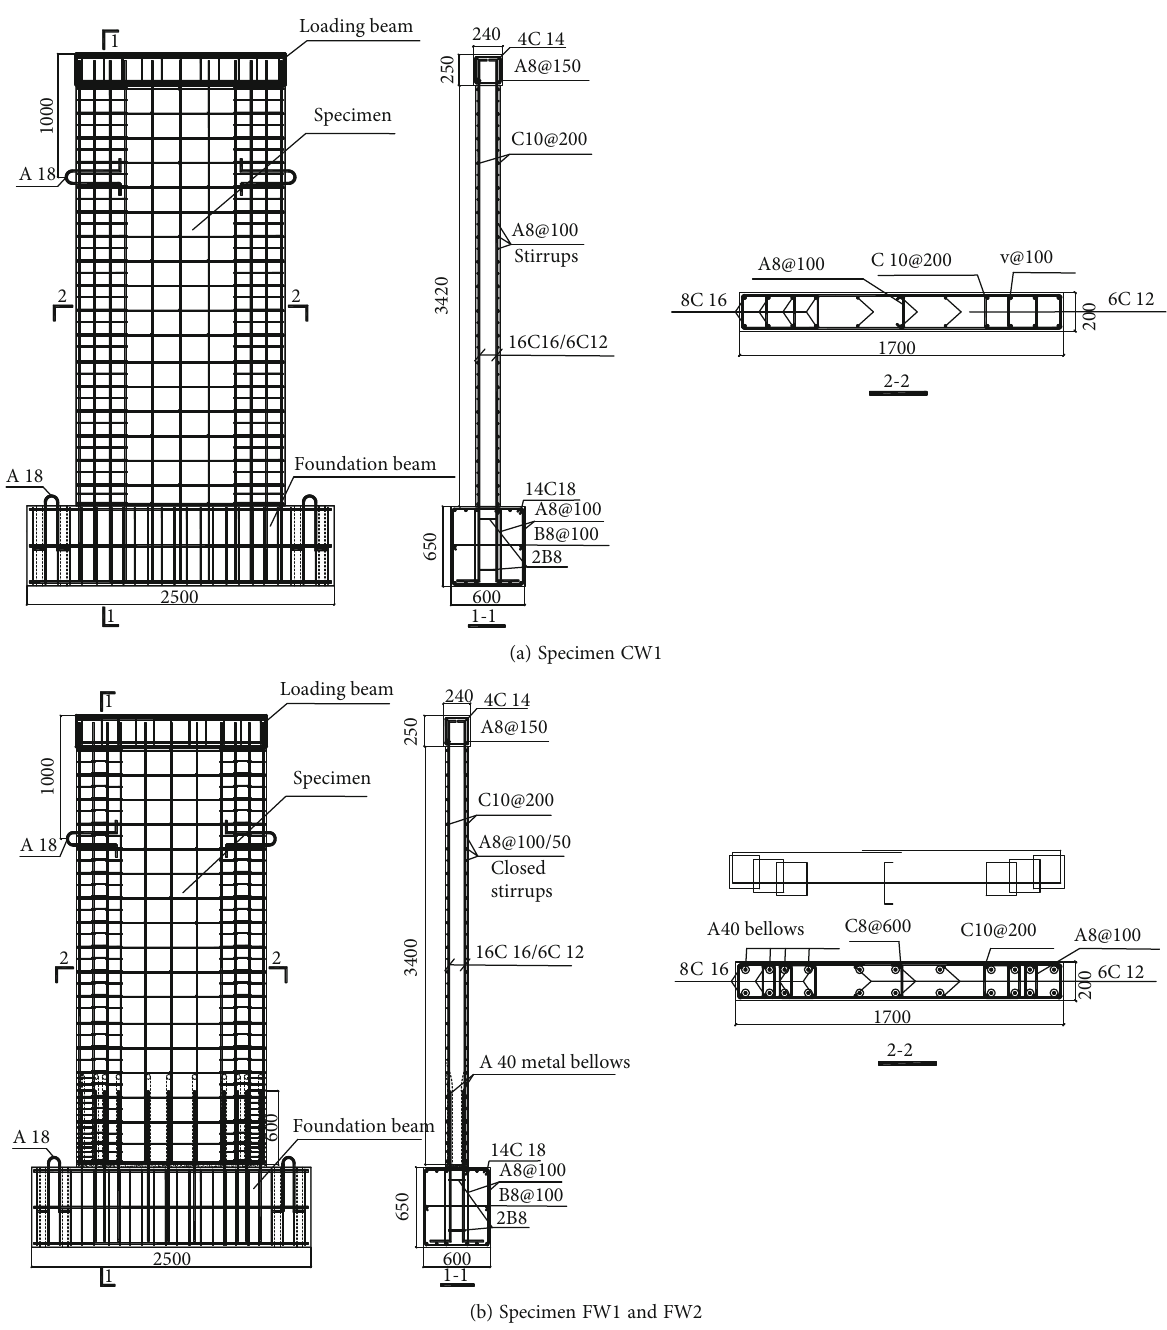
Figure 1: Dimensions and reinforcement details of the test